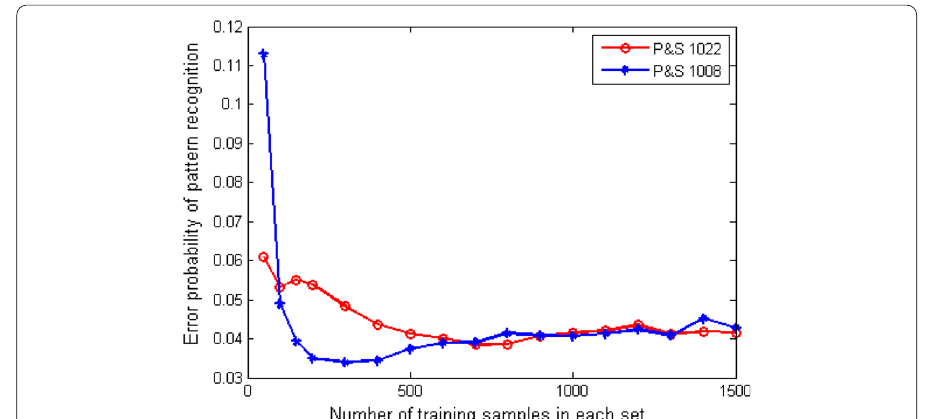
Fig. 11 Error probability versus the number of training samples for the Kendall weighted method